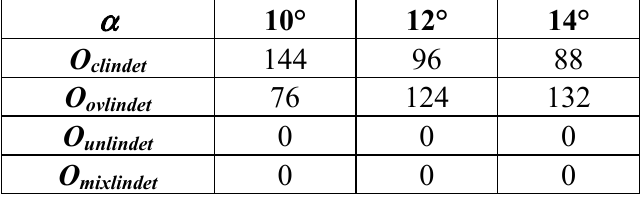
Table 5. Multi-line handwritten text segmentation test